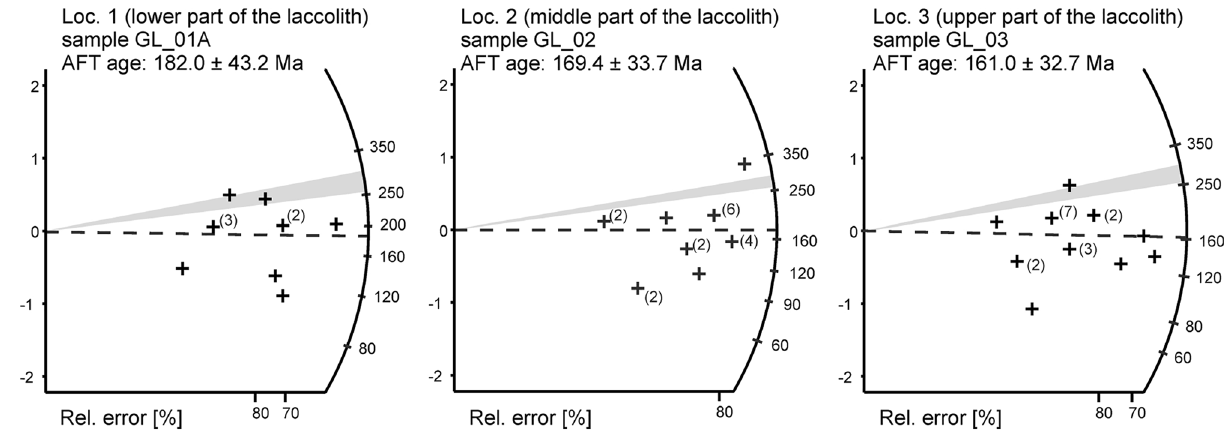
Figure 12. AFT radial plots of the samples from various areas of the laccolith from Głuszyca; Note that the inferred timing for magma emplacement is indicated by grey strips. The numbers in brackets indicate how many fluorapatite crystals yielded the same AFT age.